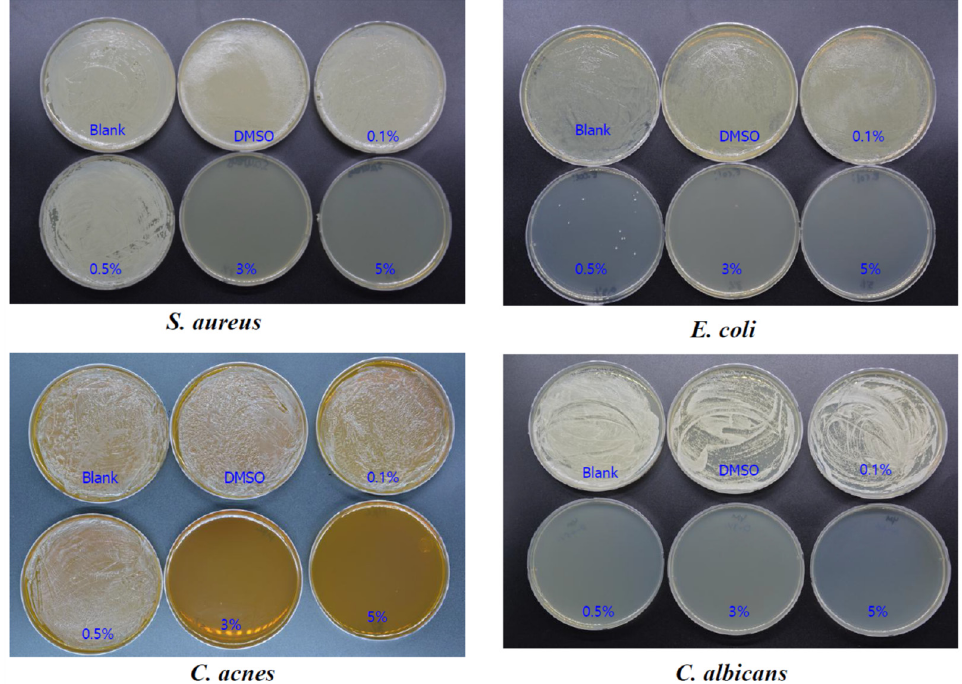
Figure 12. The antibacterial and antifungal effect of ozonated sunflower oil against four tested strains by minimal inhibitory concentration